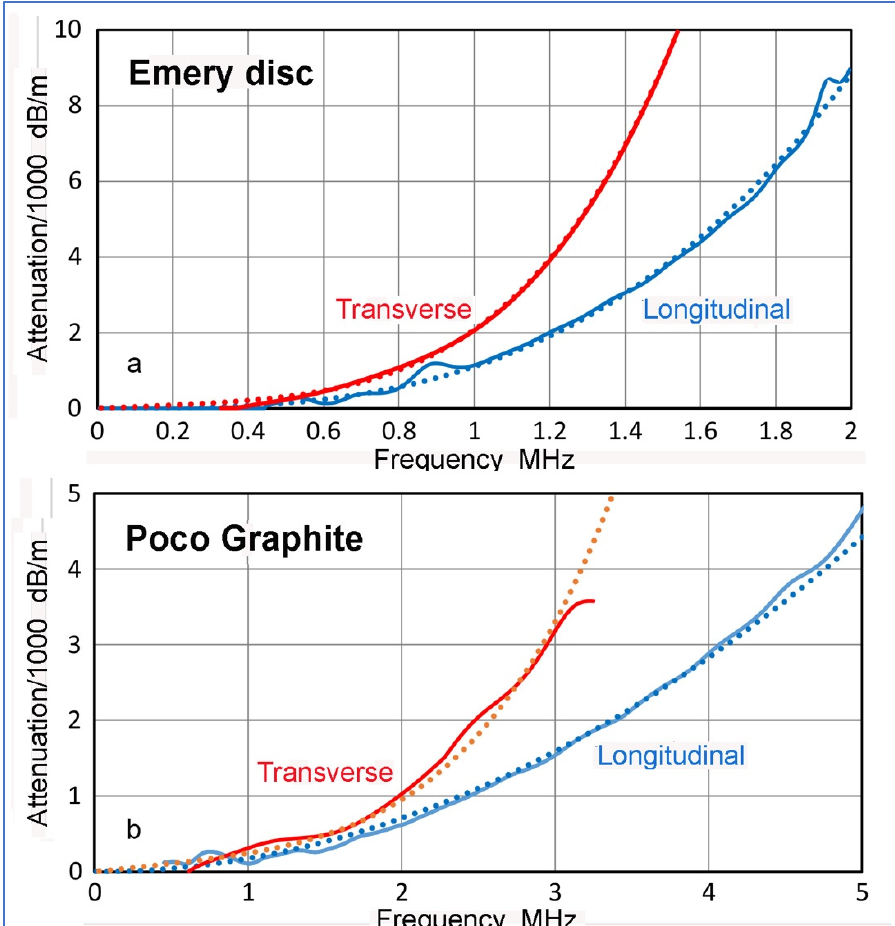
Figure 10. ( a ) Attenuation (dB/m) vs. frequency, f (MHz) for bonded emery disc. Blue solid and dotted curves are for the observed and Mason ‐ McSkimin fitted longitudinal attenuation and red solid and dotted curves are for the corresponding transverse attenuation. ( b ) Same for Poco graphite with blue and red curves for the observed longitudinal and transverse attenuation, respectively. Frequency ‐ squared dependences of longitudinal and transverse attenuation are plotted in blue and orange dotted curevs, respectively.